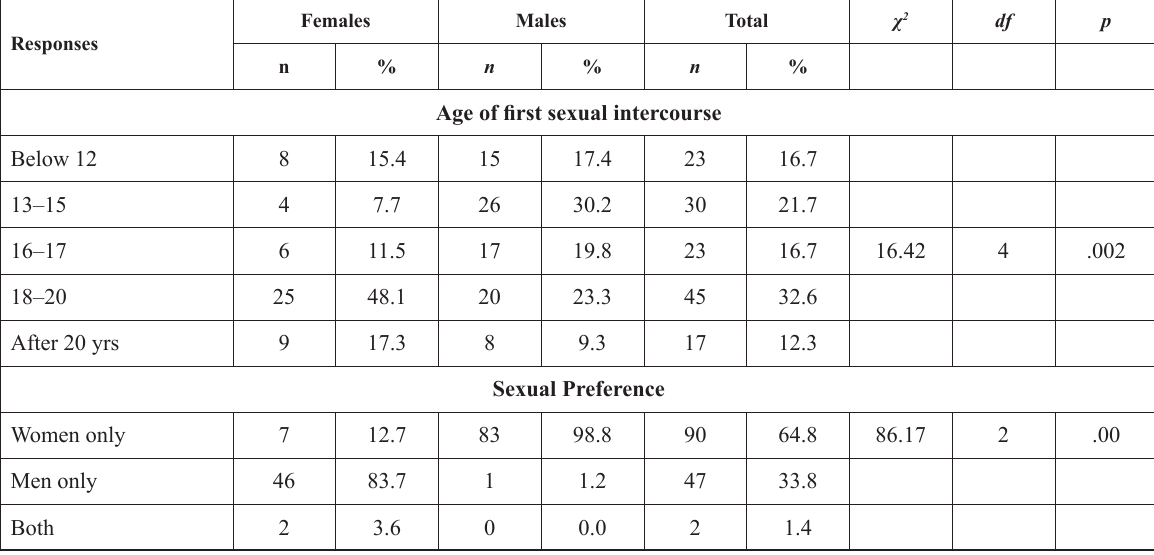
Table 2. Cross tabulation of responses on the age of first sexual intercourse and sexual preferences